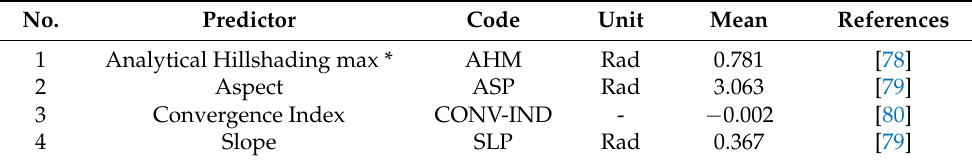
Table 1. Model of topographic indicators and related